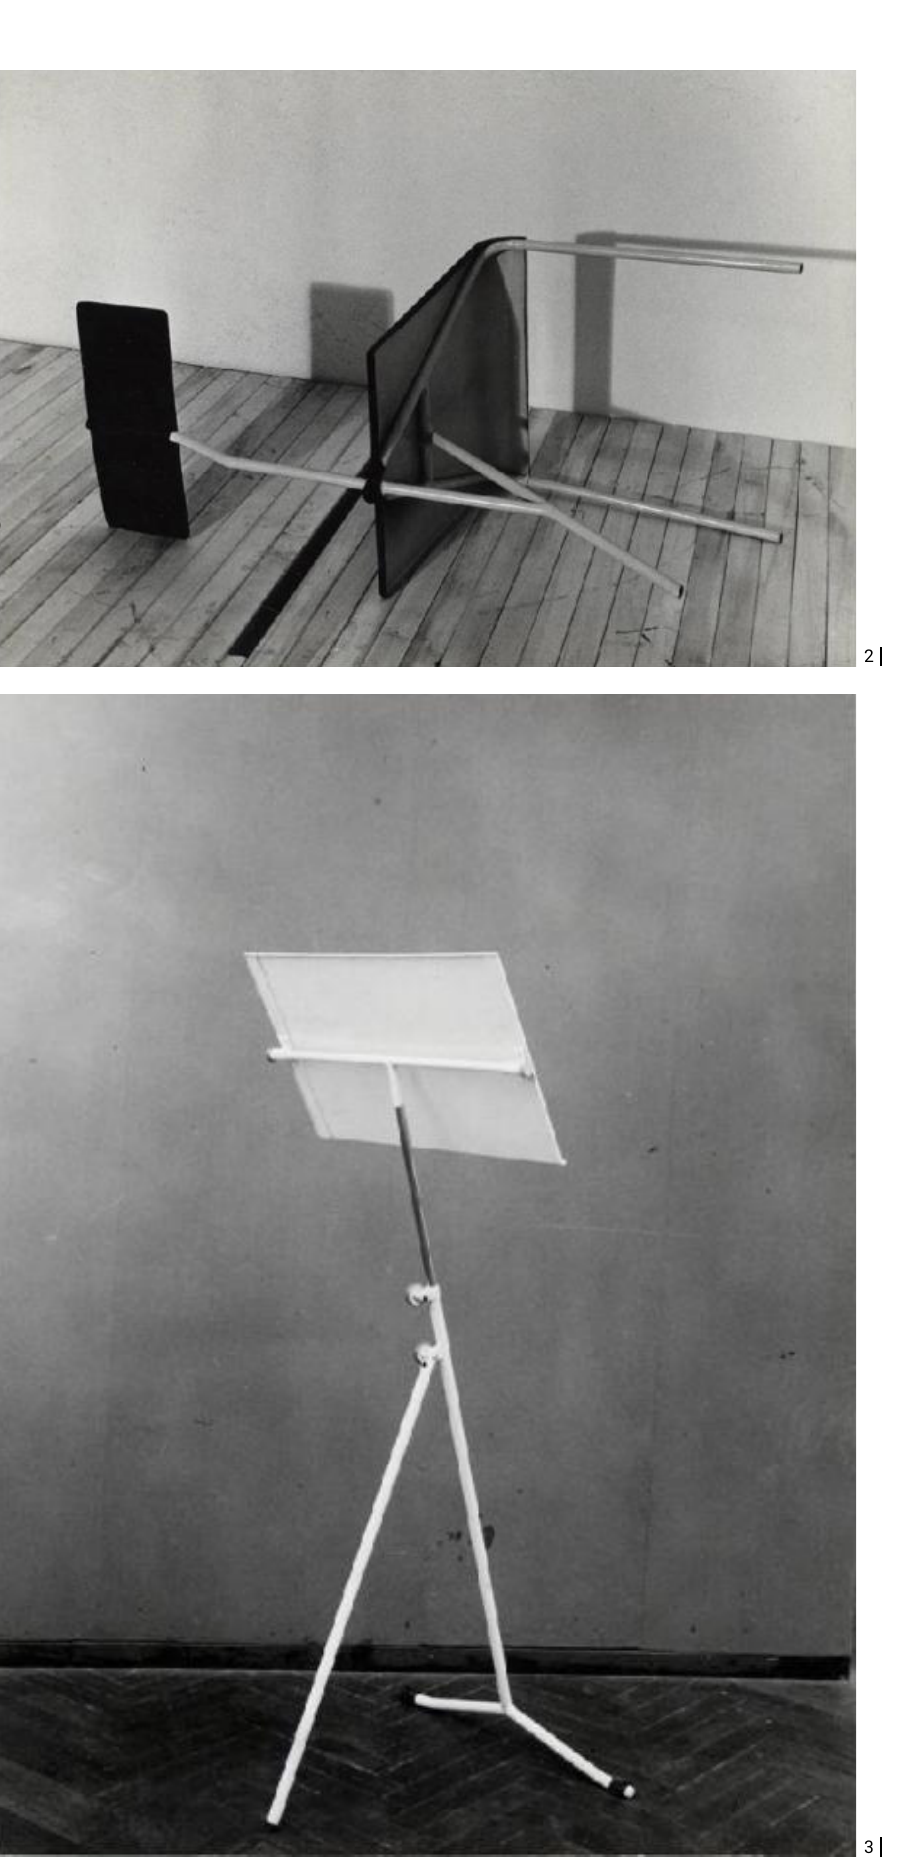
Bottom view of the tubular and metal sheet designed by Giancarlo De Carlo (Veronesi production), exhibited in VIII Triennale furniture section, part one, single furniture divided by function. (ph. N.D.) source: http://www.lombardiabenic- ulturali.it/fotografie/schede/